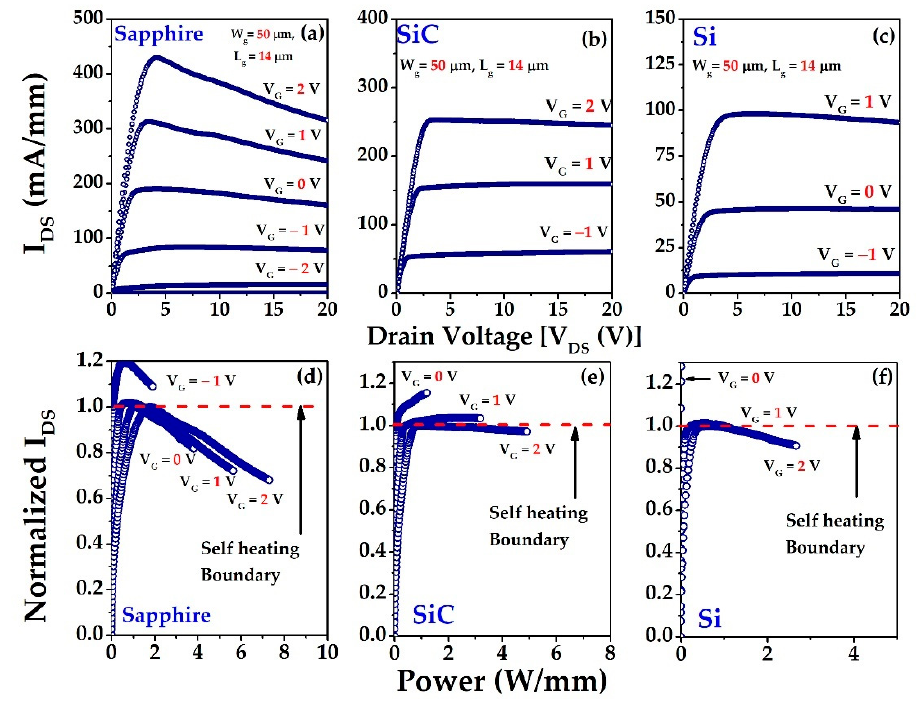
Figure 2. I–V characteristics of ( a ) sapphire, ( b ) SiC, and ( c ) Si at room temperature; the power dissipation and self-heating phenomena of ( d ) sapphire, ( e ) SiC, and ( f ) Si.